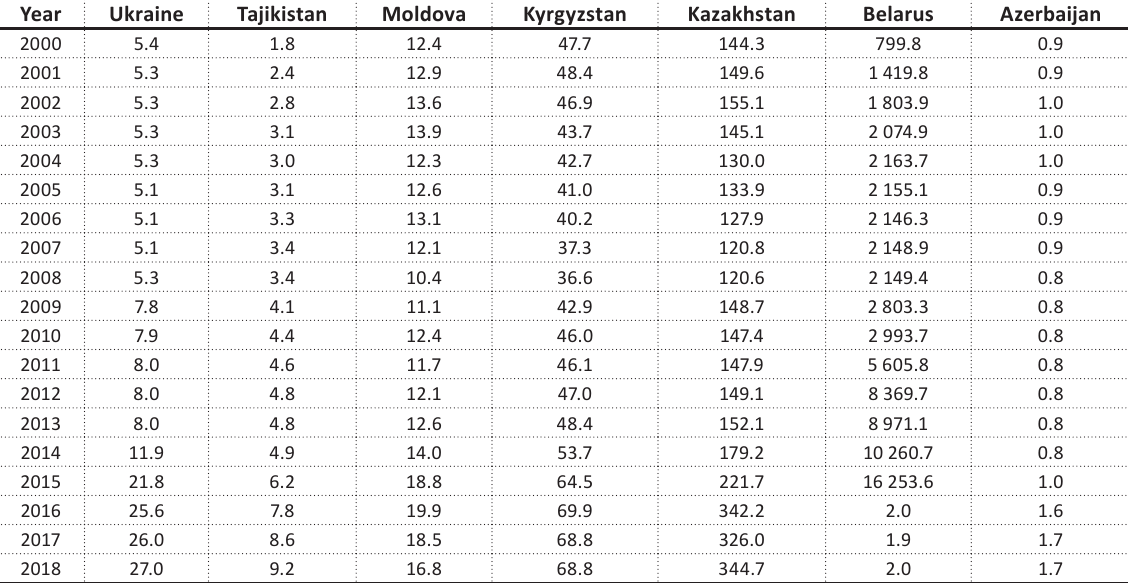
Table 3. National currency rate for USD